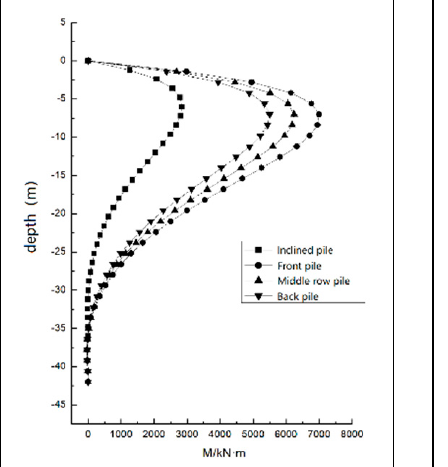
forces in the three columns is taken as the follow-up study.